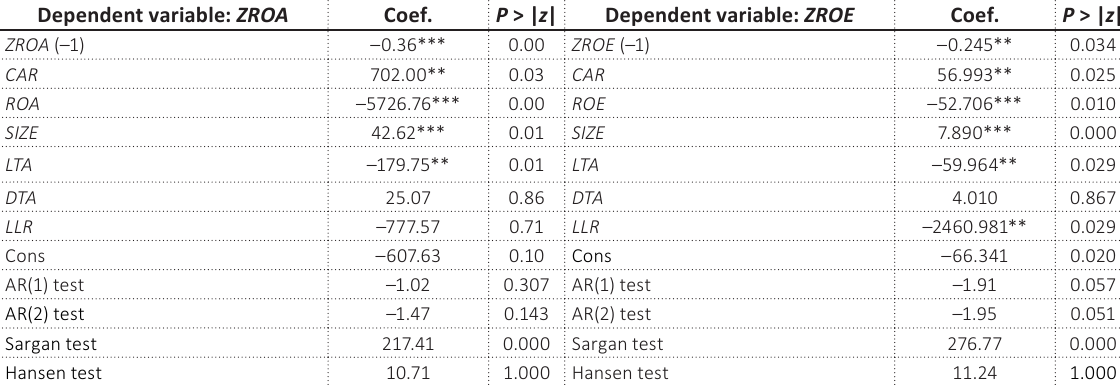
Table 4. Regression results and robustness checks